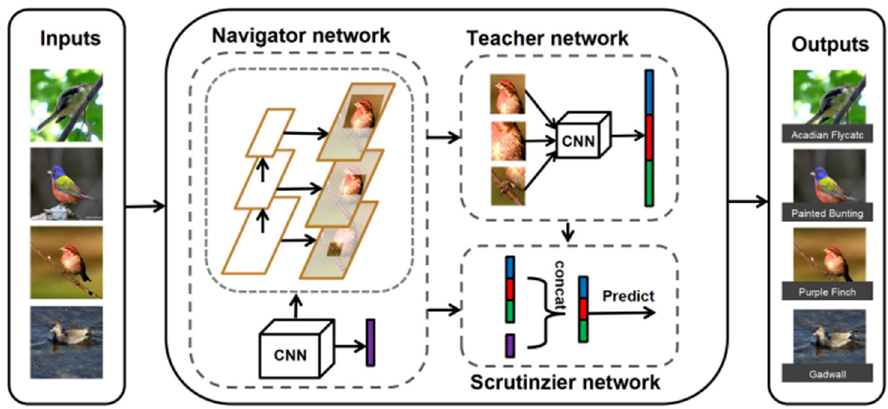
Figure 1. An illustration of the SPS, which shows how SPS exploits samples as a source for noise